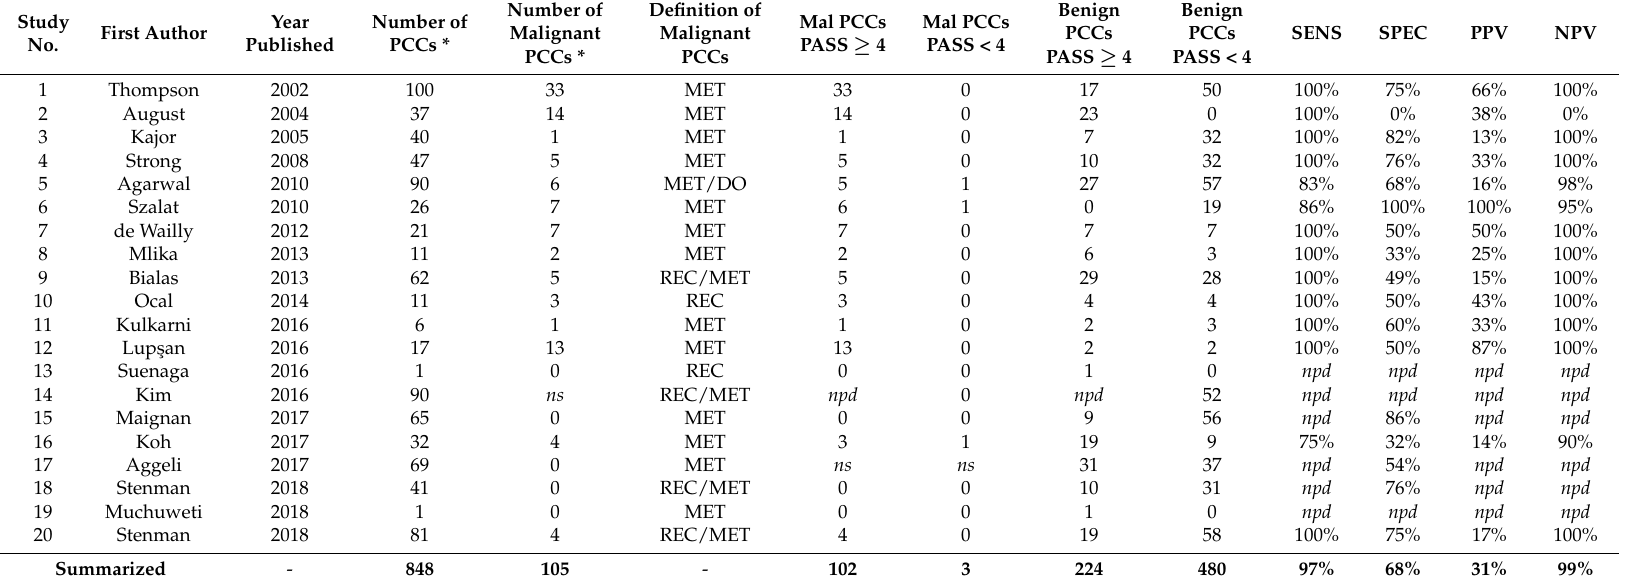
Table 1. PCC cohorts stratified by the PASS